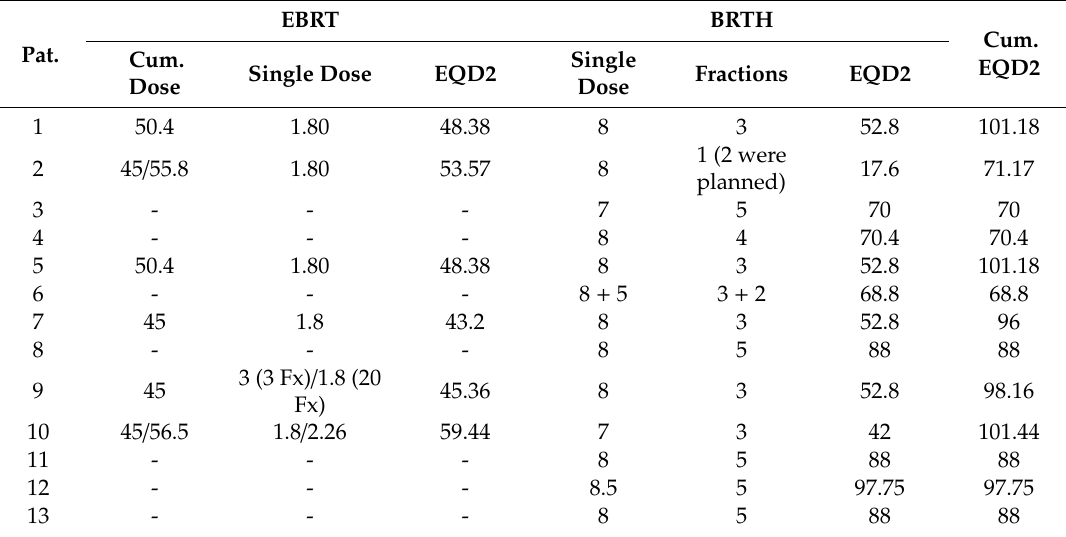
Table 3. Fractionation